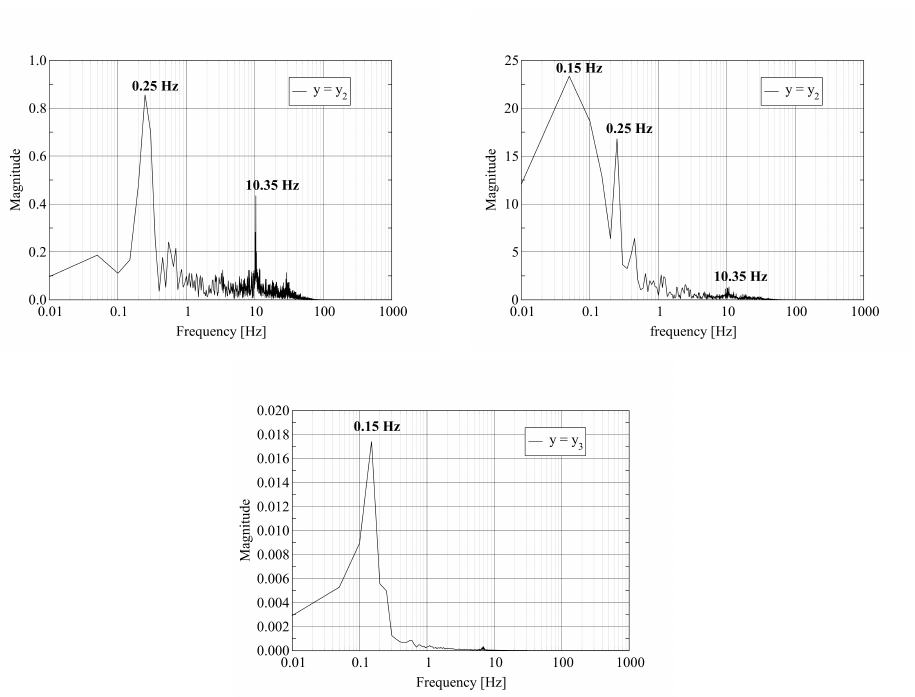
Figure 5. Discrete Fourier Transform of a transverse velocity component ( left ) and the temperature ( right ) trace at probe points located at ( 0, l i ,0 ) : where l 1 = 0.0625 L ( top ); l 2 = 0.125 L ( middle ); and l 3 = 0.9875 L ( bottom